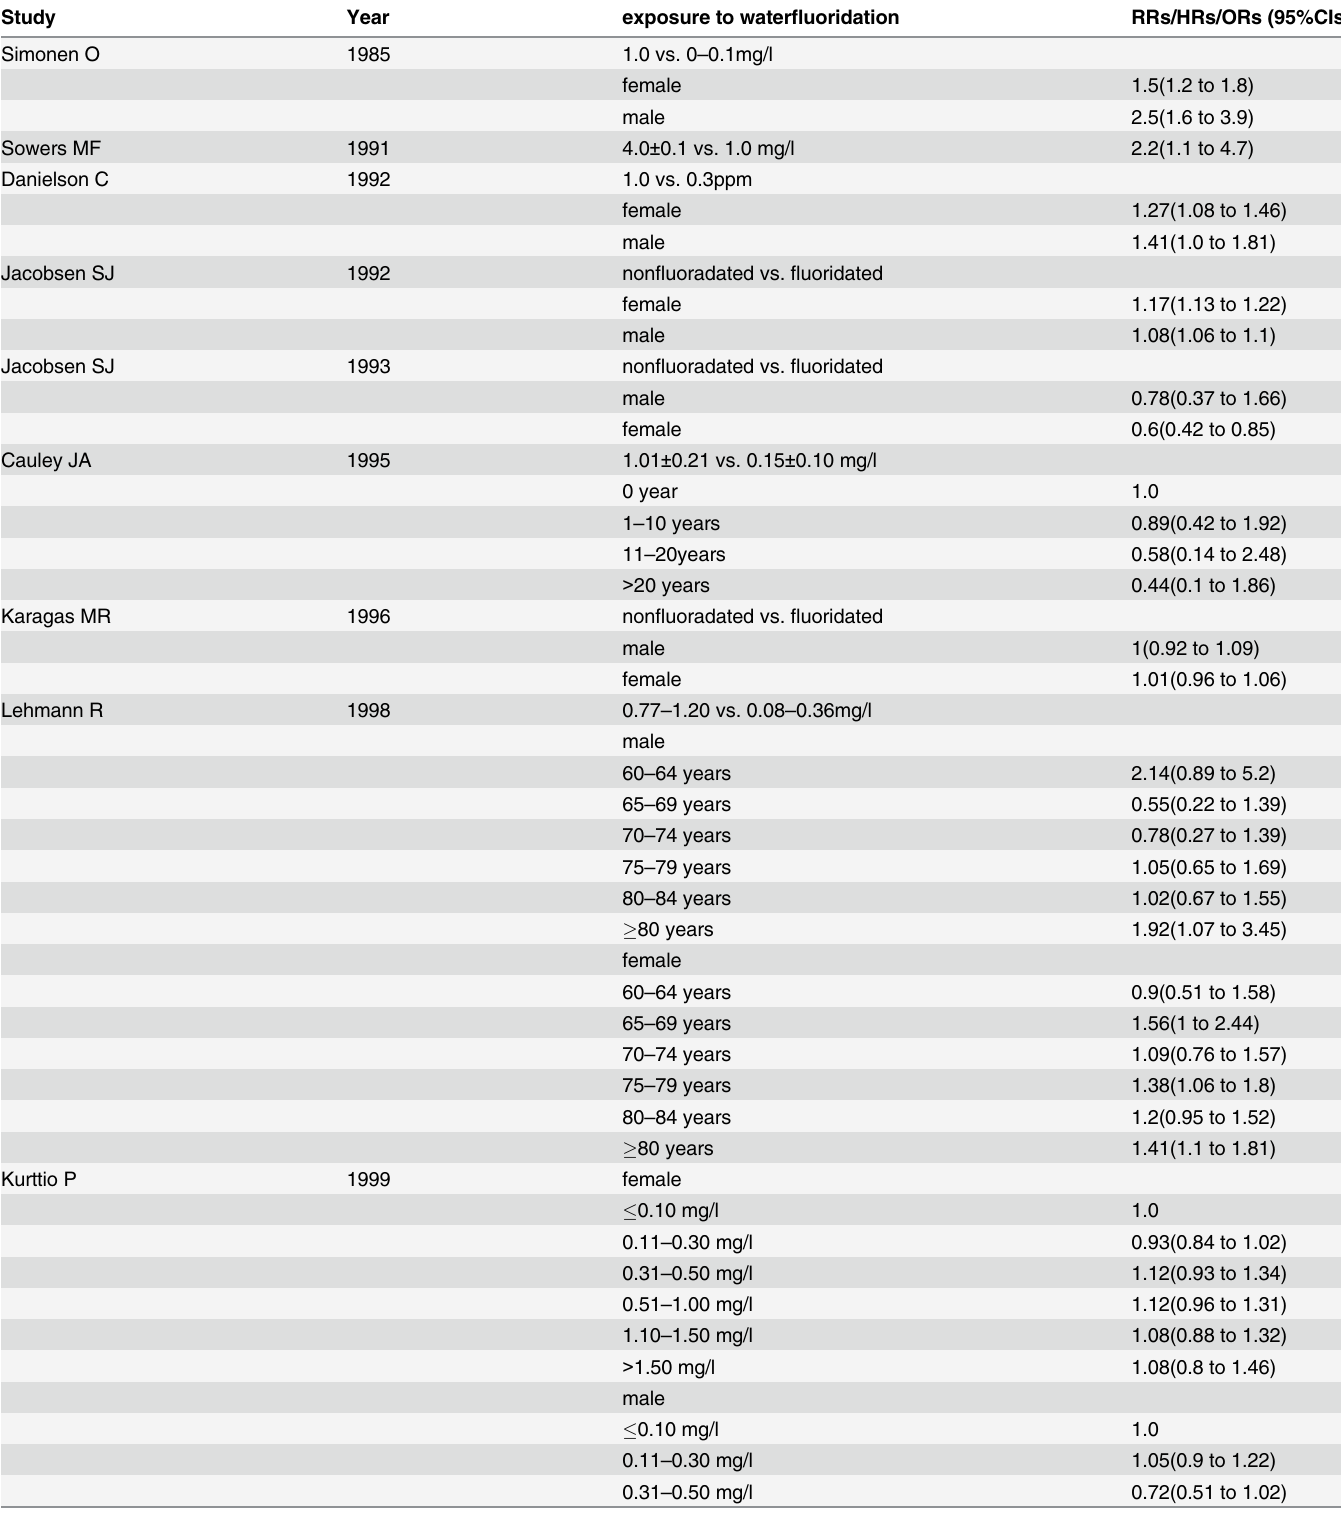
Table 2. The effect size across included